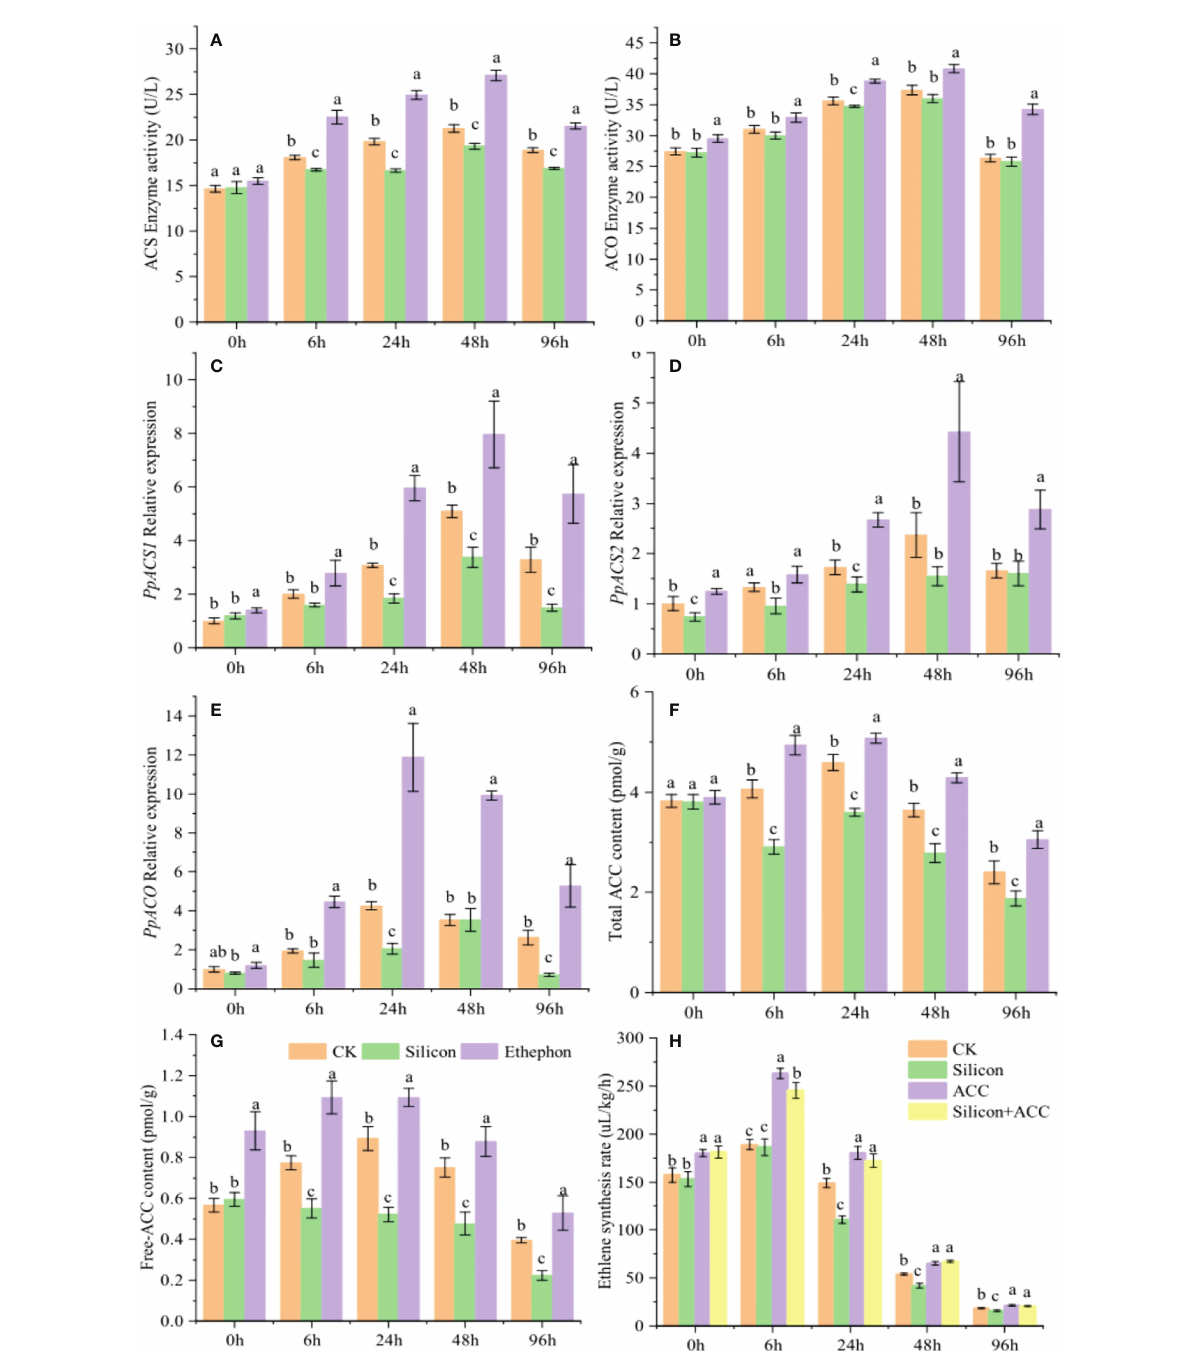
FIGURE 3 Silicon inhibits ethylene synthesis in peach shoots. Enzyme activity of ACS (A) and ACO (B) in peach shoots under different treatments. Relative expression of PpACS1 (C) , PpACS2 (D) and PpACO (E) in peach shoots under different treatments. Total ACC content (F) and free ACC content (G) of peach shoots treated with different fl uids. (H) Ethylene synthesis rate of peach shoots treated with exogenous ACC. Bars with different letters indicate signi fi cant differences (p < 0.05, Duncan ’ s multiple range